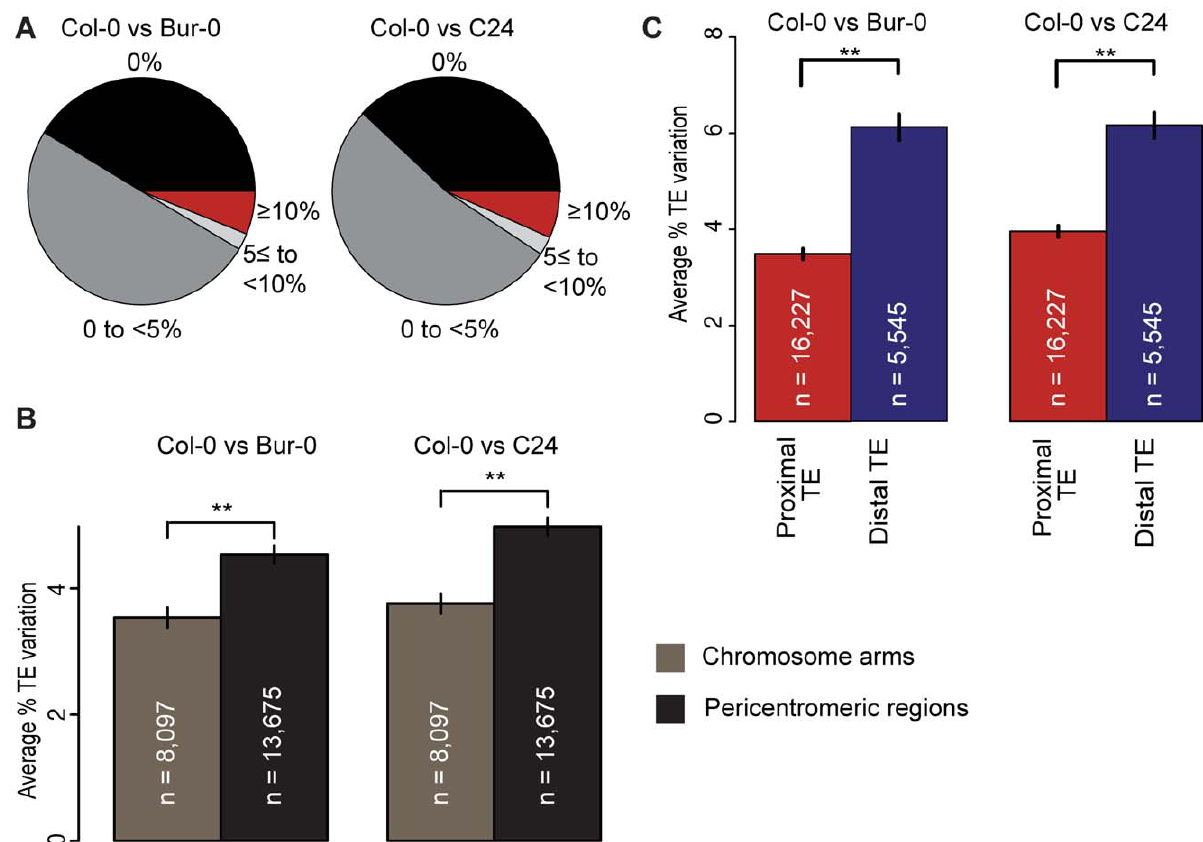
Figure 1. TE variation and its relation to coding gene proximity and genomic region. (a) TE variation between Col-0 and Bur-0 or C24, calculated as the percentage of total TE length that differs between two accessions. (b) for TEs on the chromosome arms vs the pericentromeric regions between Col-0 and Bur-0 or C24. Pericentromeric regions are defined as 8 MB regions flanking the centromeric regions (20). Mann-Whitney U [MWU] test p[Col-0/Bur-0]=0.001, p[Col-0/C24] , 6 6 10 2 5 . **=p , 0.01. Standard errors are shown. (c) Average variation of proximal TEs and distal TEs between Col-0 and Bur-0 or C24 (MWU, p , 2 6 10 2 16 for Col-0 versus Bur-0/C24).